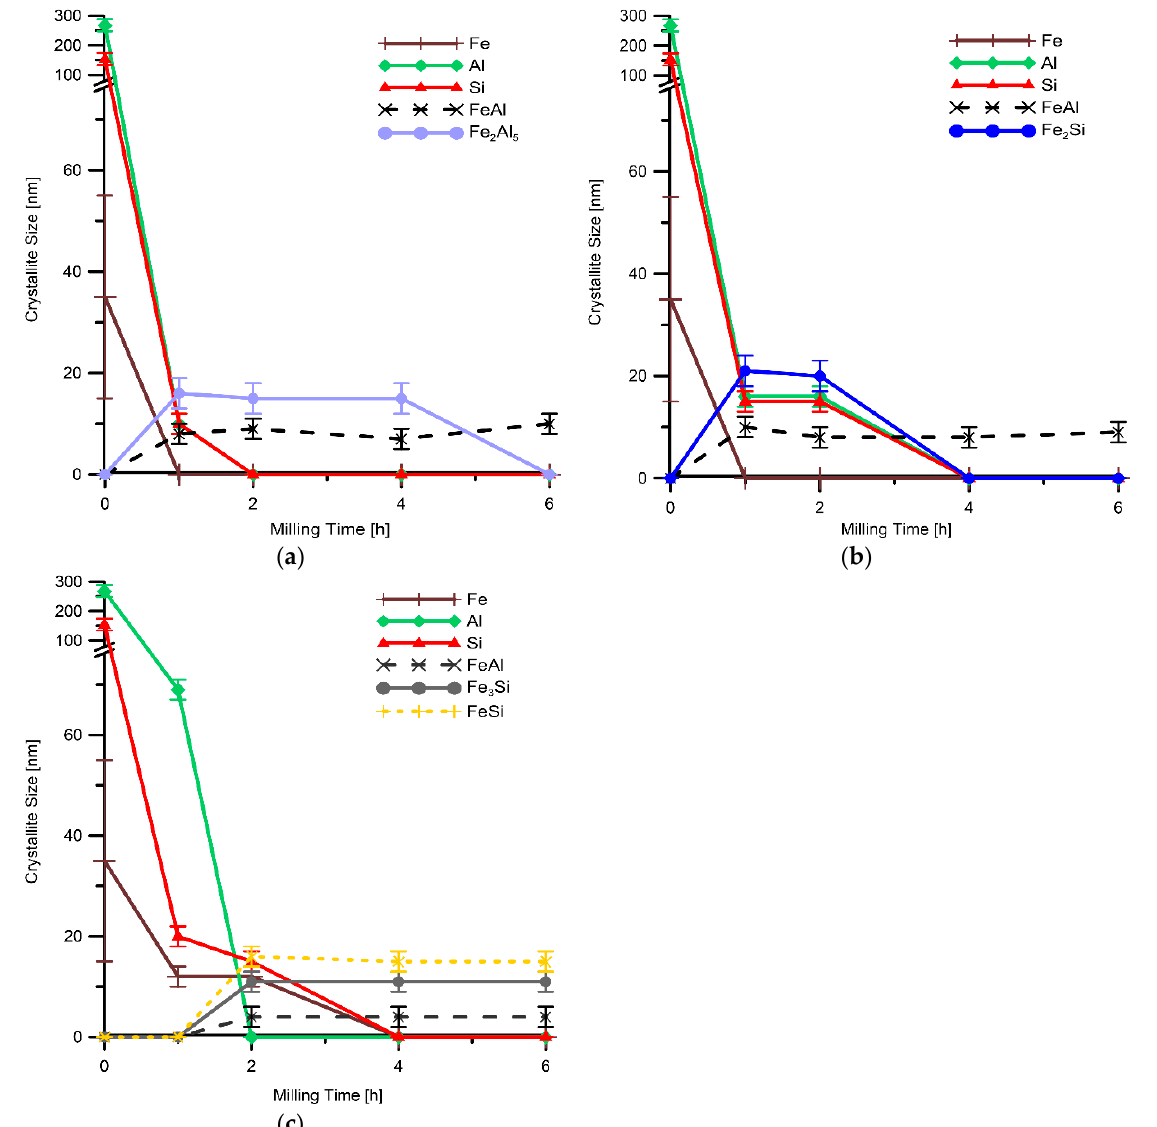
Figure 7. Crystallite size vs. milling time for: ( a ) FeAl35Si5, ( b ) FeAl30Si10 and ( c ) FeAl20Si20 alloy.